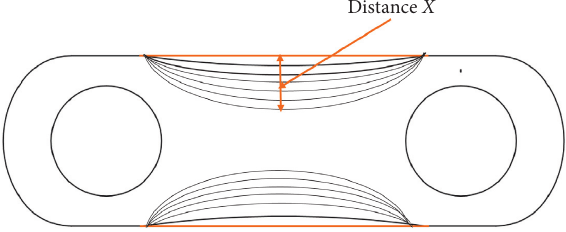
Figure 3: Varying distance X